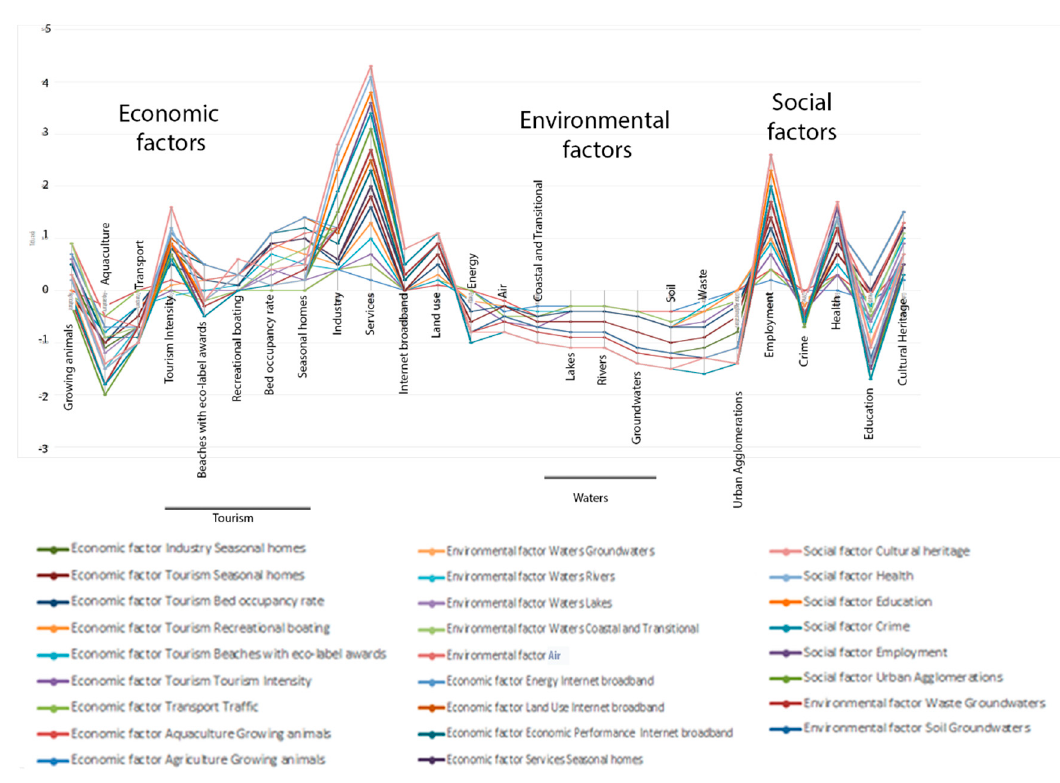
Figure 6. Graphic representation of the impact between the activities in the coastal area (author).